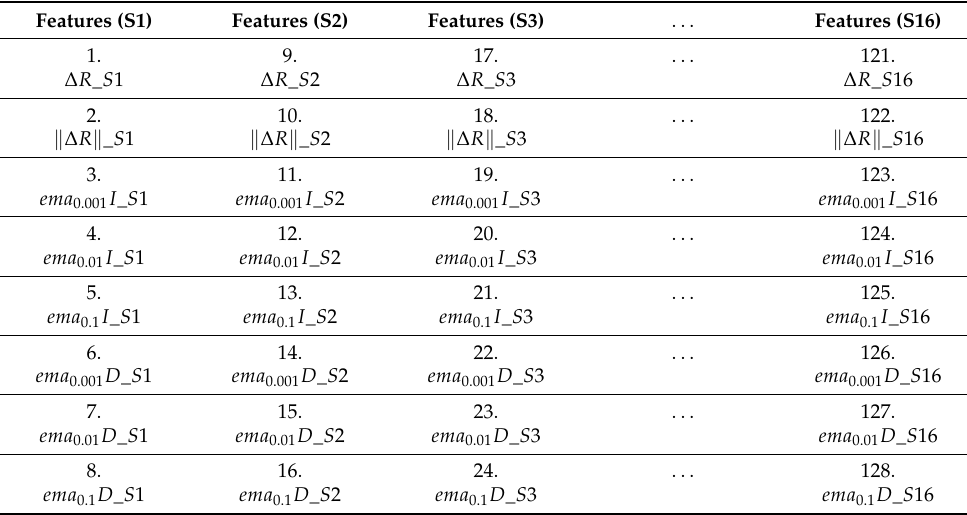
Table 2. Placement order of extracted features in the feature